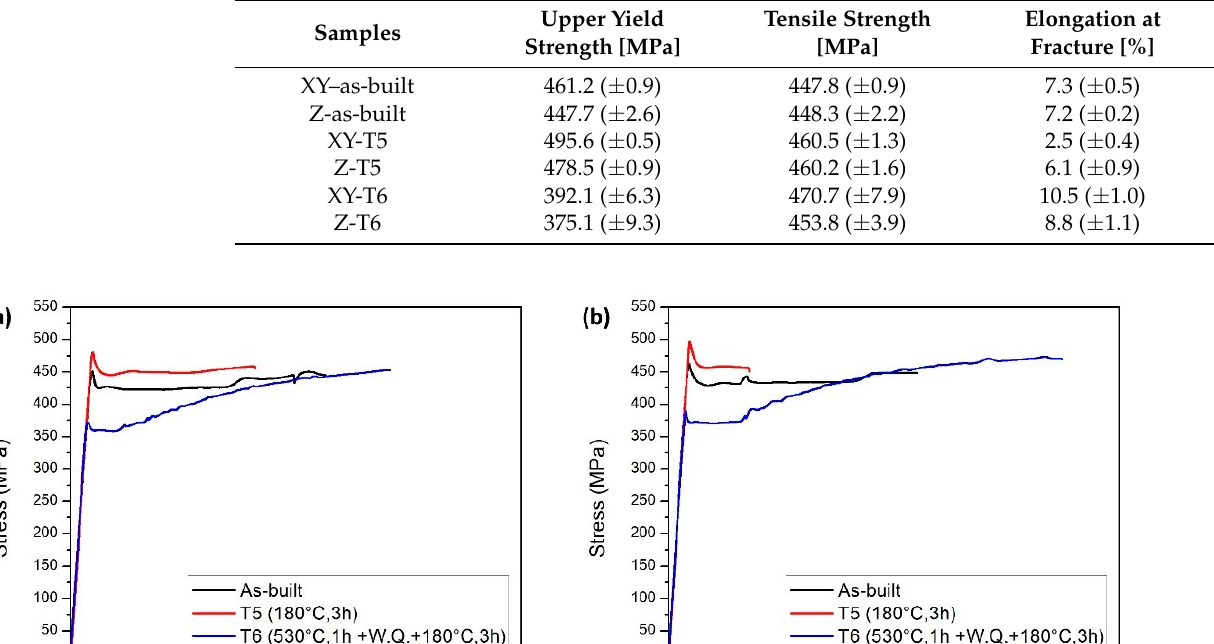
Figure 7. SE-SEM images of artificially-aged ( a ) as-built and ( b ) solution treated samples after Kel- ler’s etching.